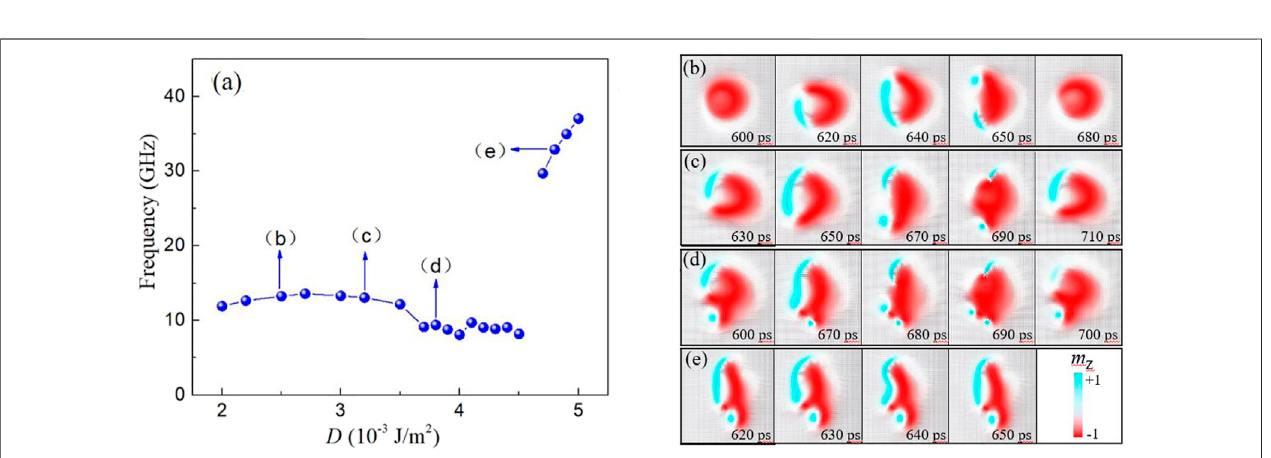
Frontiers in Physics |